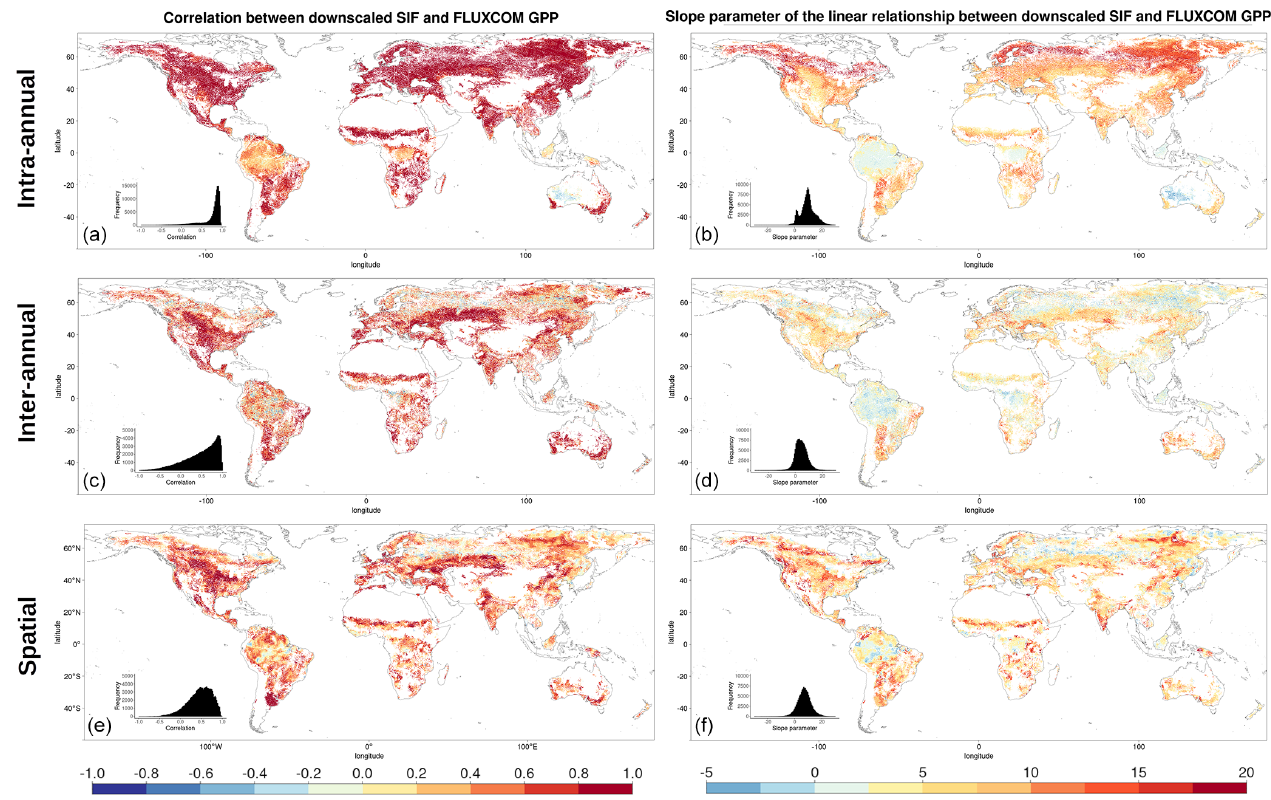
Figure 3. Pearson’s correlation coefficient, r , (a, c, e) and the linear model slope parameter (b, d, f) for the following: (a, b) the intra-annual temporal relationship between the downscaled SIF and FLUXCOM GPP over 8d time steps within a growing season; (c, d) the inter-annual temporal relationship between the mean annual downscaled SIF and mean annual FLUXCOM GPP; (e, f) the spatial relationship between the mean annual downscaled SIF and mean annual FLUXCOM GPP, with the correlation determined for a given dominant vegetation cover and climate zone over a 2 . 5 ◦ moving